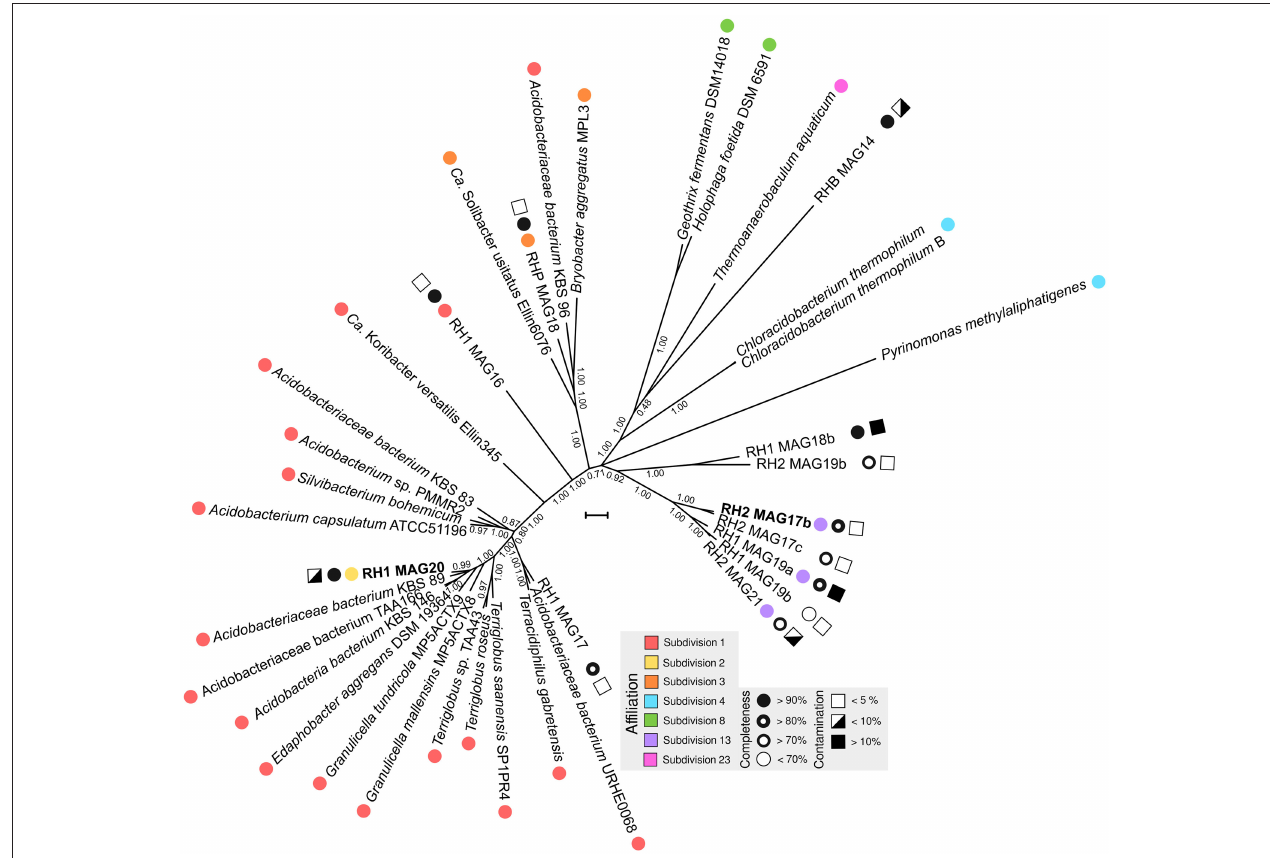
FIGURE 3 | Phylogenetic tree of MAGs. Available Acidobacteria genomes of known phylogenetic affiliation were retrieved from the NCBI genome repository. Phylogenetic treeing was based on a concatenated alignment of 31 single-copy marker genes using AMPHORA (v. 2) (Wu and Scott, 2012). Using FASTTREE (v. 2.1.3) ( Price et al., 2010), a maximum-likelihood tree was calculated applying the WAG model (Whelan and Goldman, 2001). Nearest neighbor interchange and the CAT approximation were used to optimize tree topology and to consider evolutionary rate heterogeneity ( Stamatakis, 2014). Colored circles indicate the taxonomic affiliation based on available 16S rRNA gene sequences. Black-white spheres and squares show the degree of completeness and contamination, which was derived from the presence/absence of single-copy marker genes and their actual copy number in the MAGs ( Parks et al., 2015). MAGs analyzed in more detail are highlighted in bold. The scale bar indicates 0.1 substitutions per amino acid